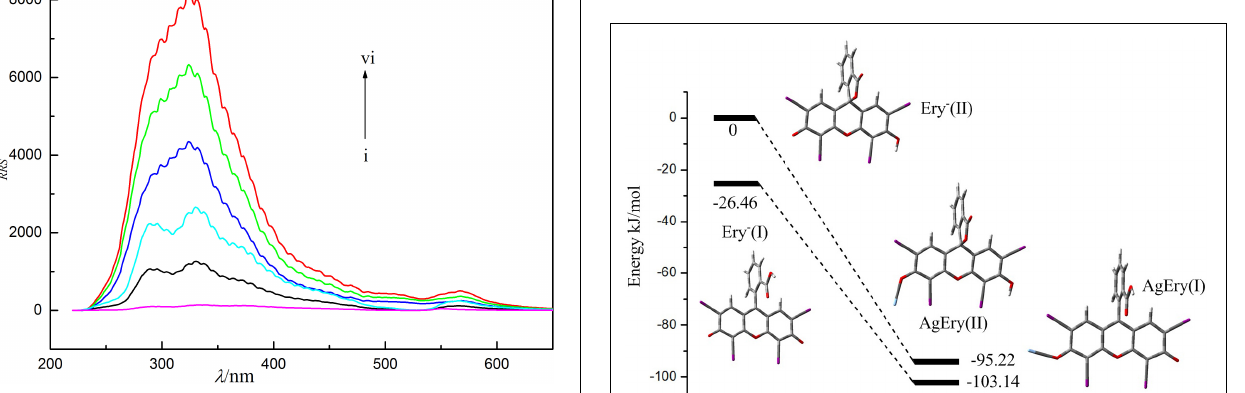
FIGURE 3 | The reaction coordination and energy surface of Ag(I) and Ery −